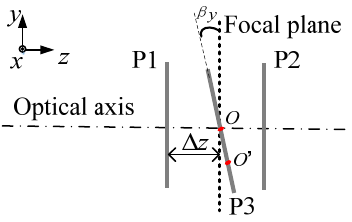
Figure 2. Area-array device deviating from focal plane.